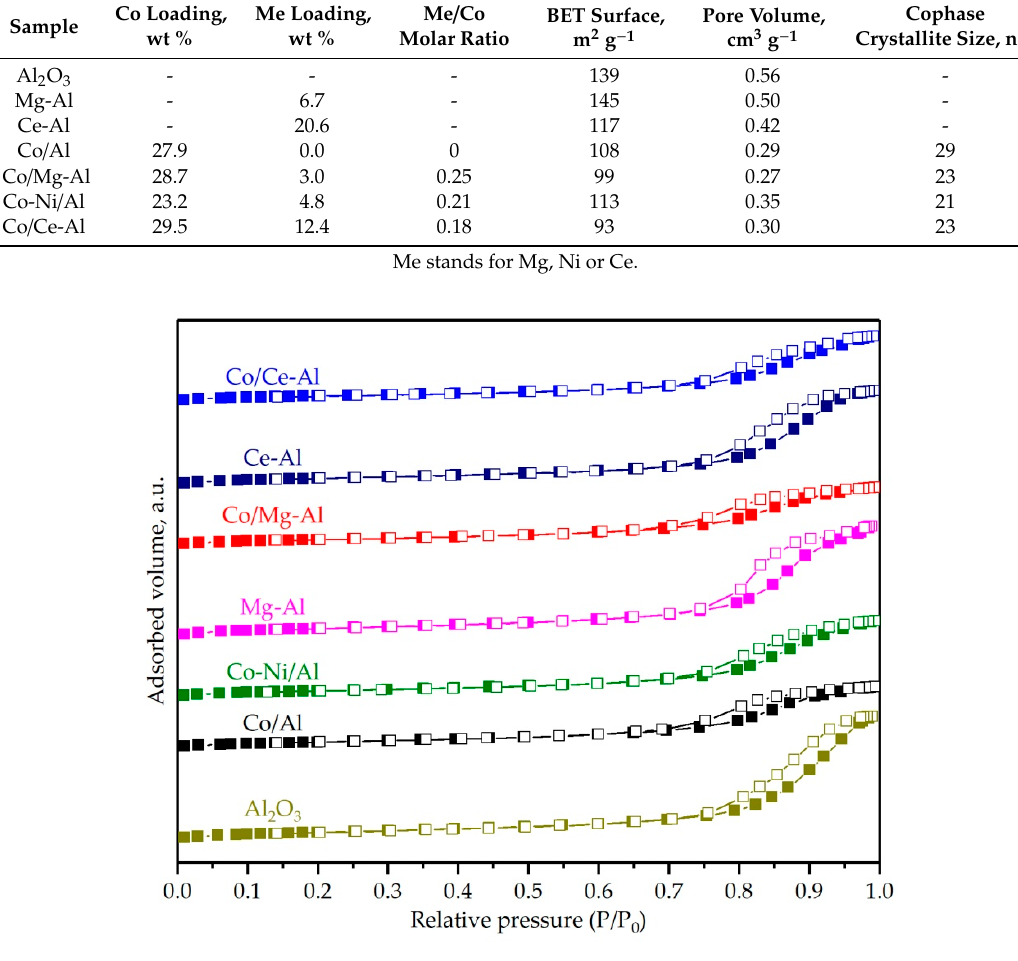
Figure 1. N 2 physisorption isotherms of the supported cobalt catalysts. Table 1. Physico ‐ chemical properties of the supported cobalt catalysts.